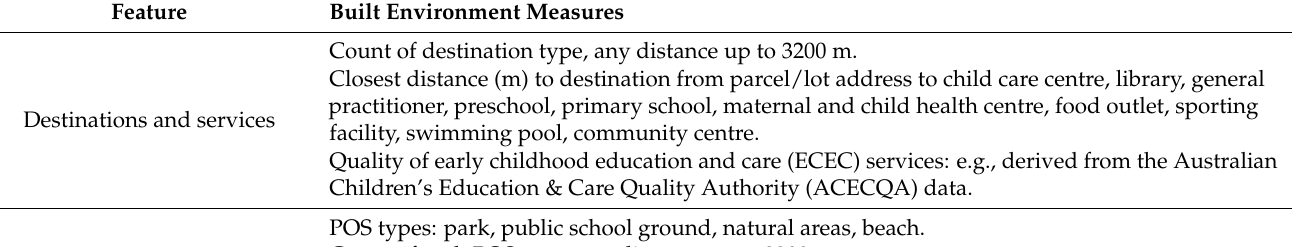
Table 1. Examples of built environment measures available in the AEDC-BE. Feature Built Environment